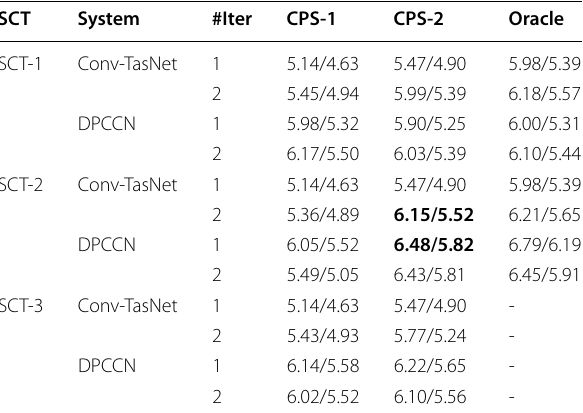
Table 5 SDRi/SI-SNRi (dB) performance of Conv-TasNet